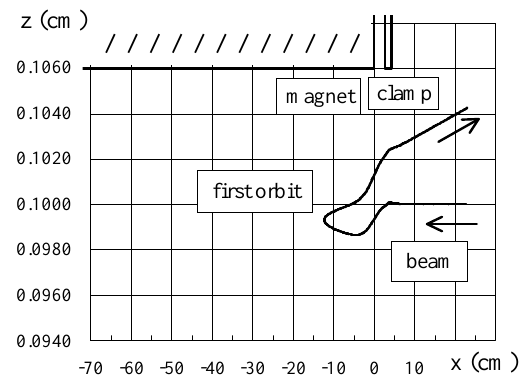
FIG. 5. First orbit trajectory of a particle coming into the reverse fringe field 0.1 cm above the middle plane.